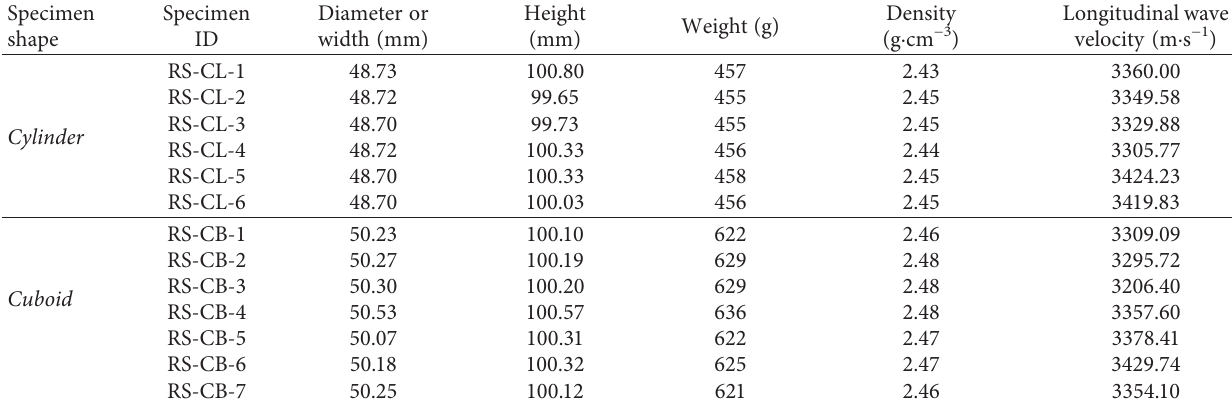
Table 1: Basic parameters of specimens.